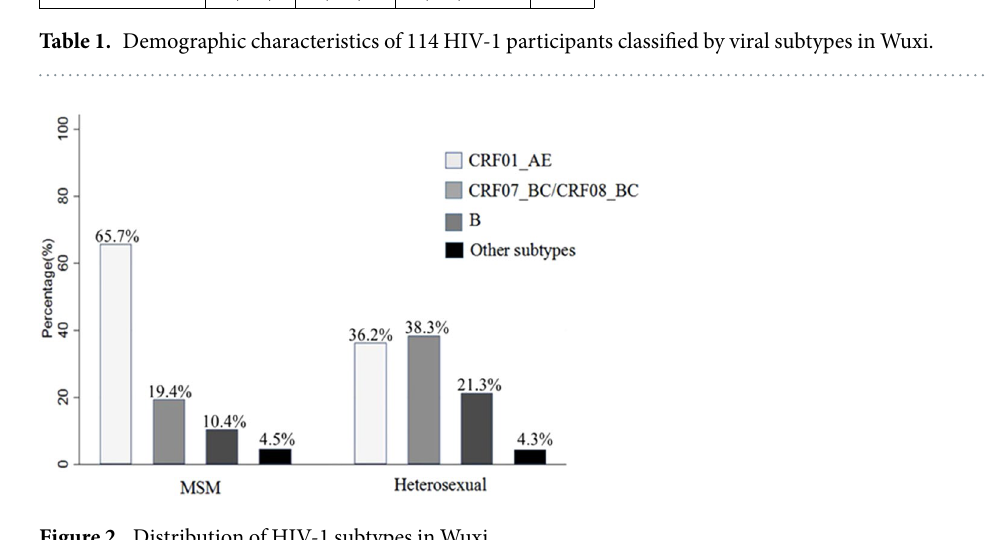
Figure 2. Distribution of HIV-1 subtypes in